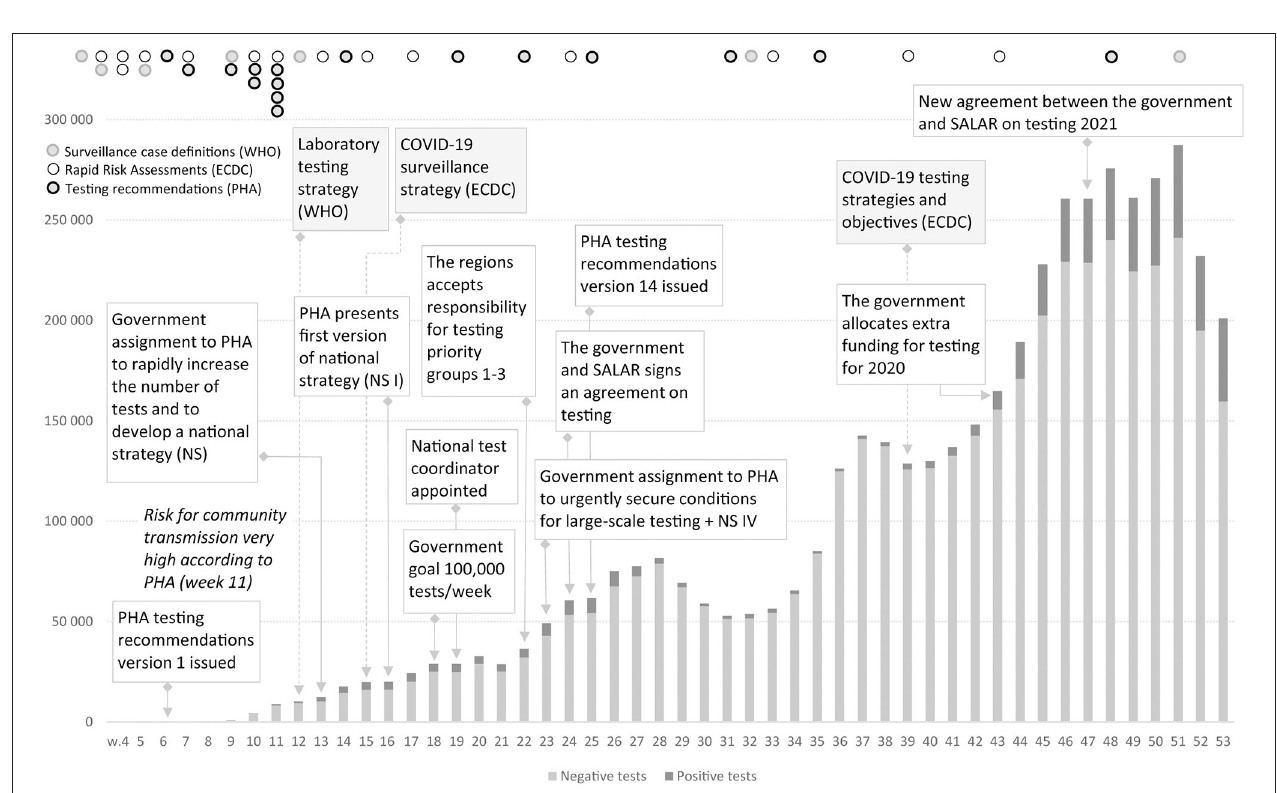
FIGURE 3 | Positive and negative COVID-19 tests in Sweden during 2020, Weeks 1–53, 2020. There are minor variations in the weekly reports on the number of tests taken and number of detected cases. https://www.folkhalsomyndigheten.se/folkhalsorapportering-statistik/statistik-a-o/sjukdomsstatistik/covid-19-veckorapporter/.